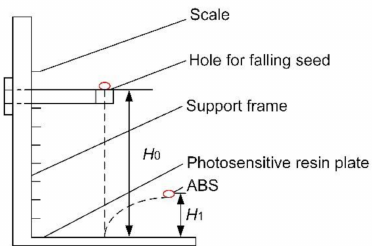
Figure 3. Schematic of ABS–PRP collision. The vertical distance H 0 from the hole to the PRP was 220 mm. During the measure- ment, 20 ABS were randomly selected, and each ABS bounced up after the hole fell freely and collided with the PRP. The process of the test was recorded by a high-speed camera. After the completion of the experiment, the maximum bounce height H 1 (mm) of 20 ABS after collision was read in the post-processing software I-SPEED